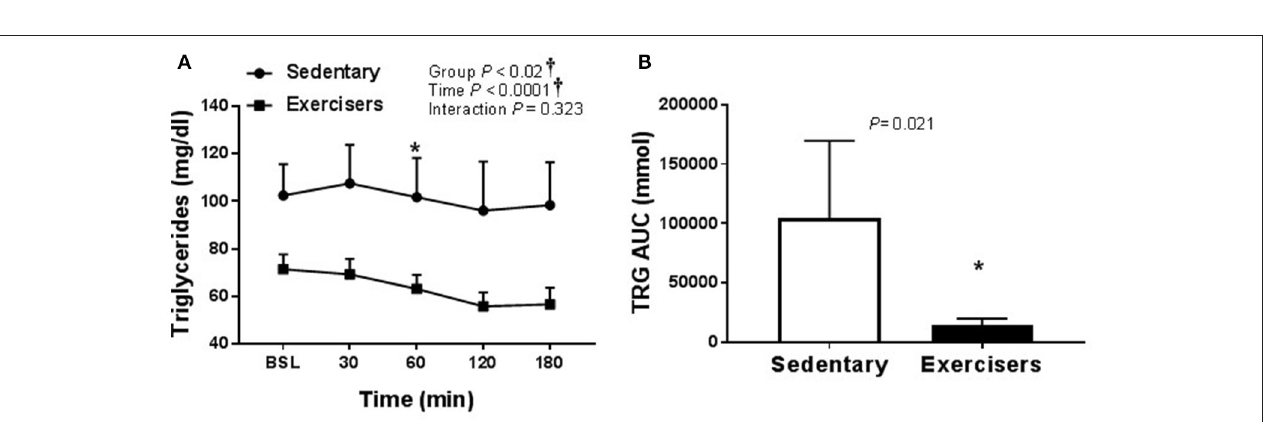
FIGURE 6 | Serum triglycerides responses to a 75g glucose high sugar meal (HSM) at baseline, and 30, 60, 120, and 180min post-ingestion in sedentary participants ( n = 11) and exercisers ( n = 33). (A) Serum triglyceride levels over 180min. and (B) Serum triglyceride area under the curve (AUC) over the 180min postprandial period. All data presented as mean ± SEM. † Indicates significant main or interaction effect ( P < 0.05). *Indicates significant difference between sedentary participants and exercisers (adjusted P < 0.05; Sidak-Bonferroni adjustment for ANOVA multiple comparisons).